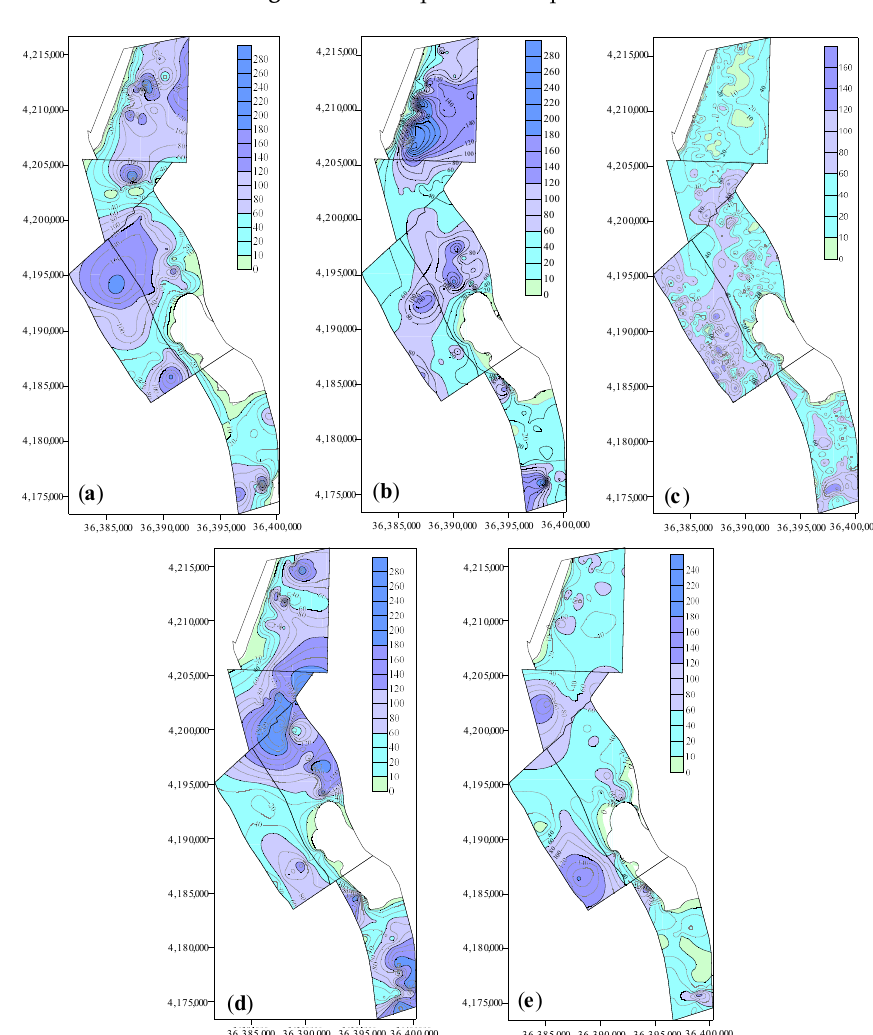
Figure 3. Thickness contour map of aquifers and aquicludes in Zhiluo formation: aquifer I ( a ), aquifer II ( b ), aquifer III ( c ), Aquiclude II ( d ), Aquiclude III ( e